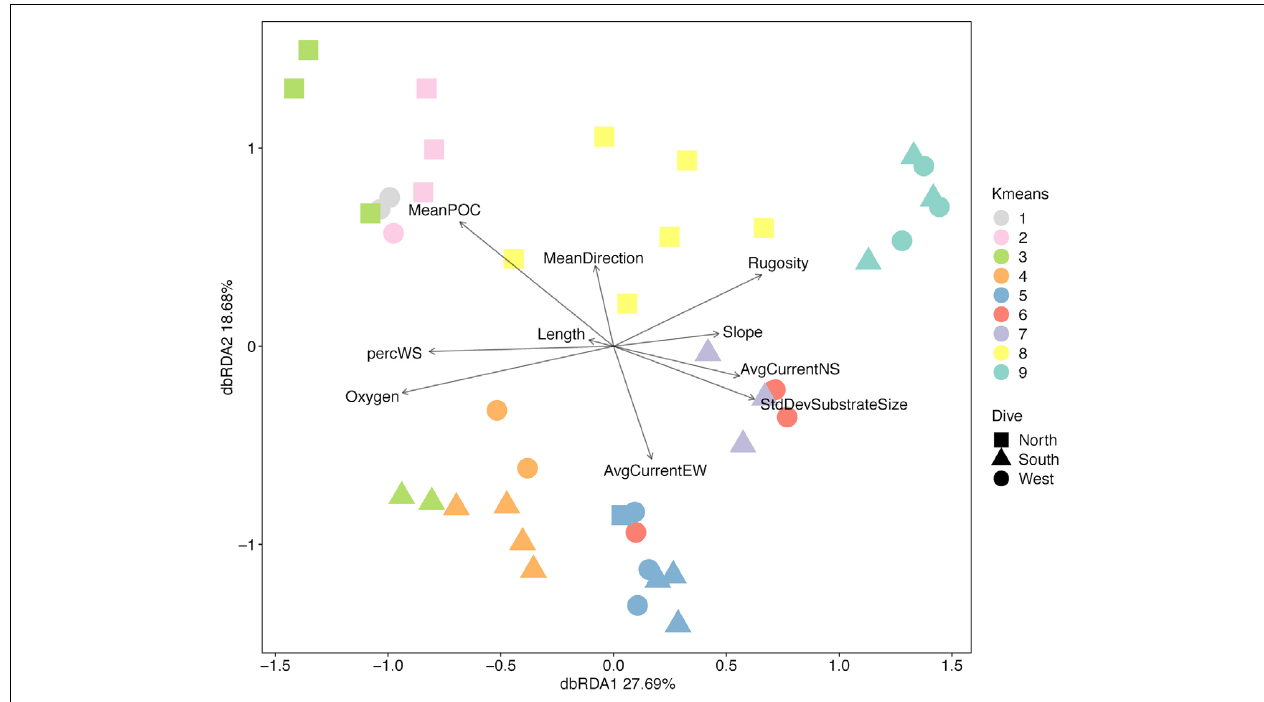
FIGURE 11 | Distance-based redundancy analysis diagram for three slopes of Mokumanamana.